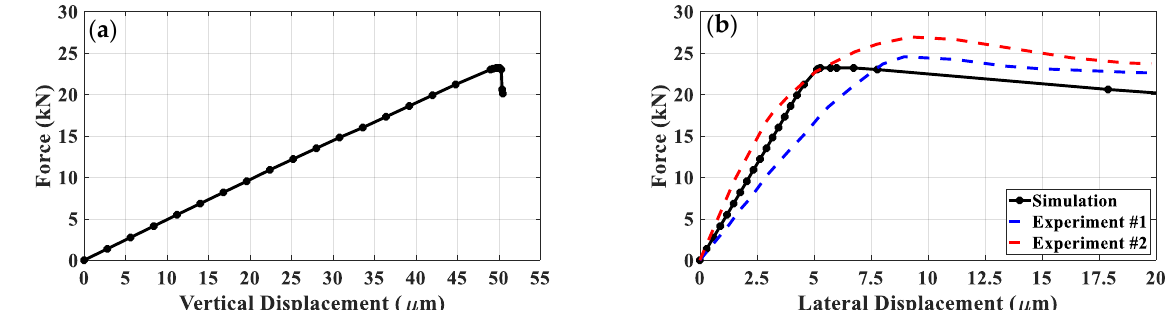
Figure 2. ( a ) Load-vertical displacement and ( b ) load-lateral displacement characteristics for the hydromechanical axial splitting test.